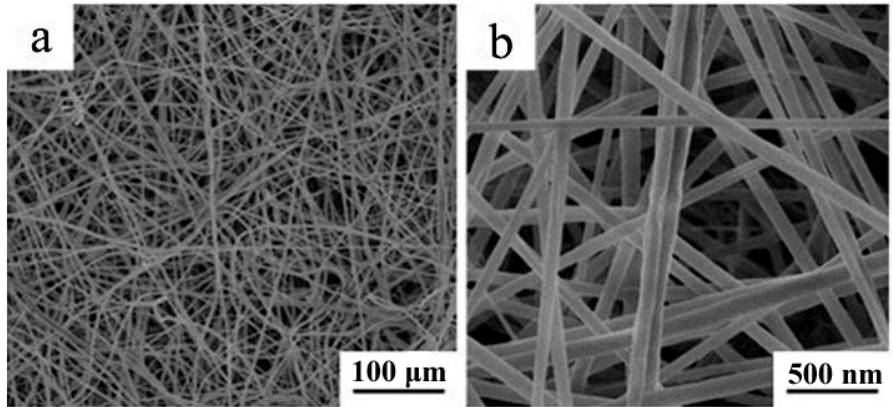
Figure 2. SEM images of the PN@8 wt%Ag-2 h nano fi ber membrane ( a , b ).